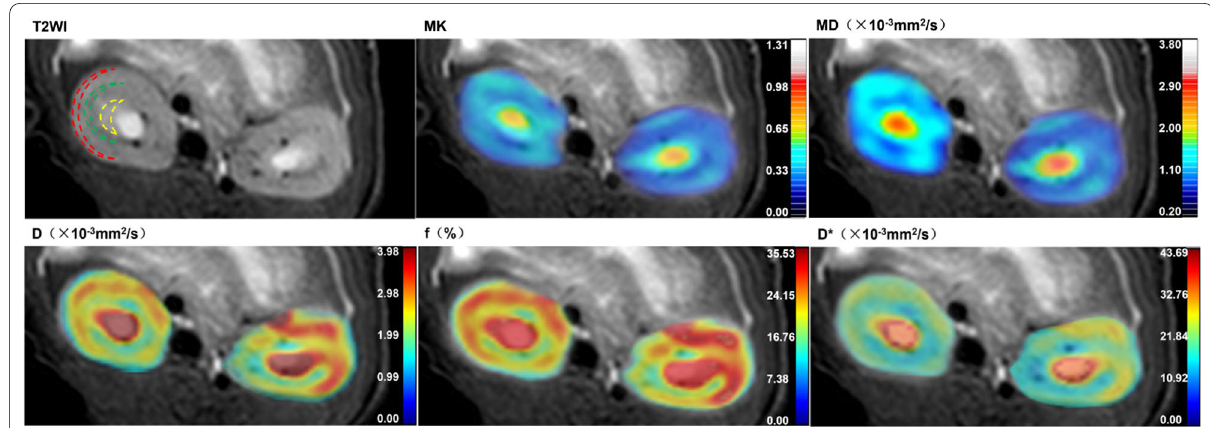
Fig. 2 Representative T2-weighted image, MK, MD, D , f , and D * maps of a rat kidney. T2WI of the kidney showing the location of three ROIs: the CO (the red areas), OM (the green areas), and IM (the yellow